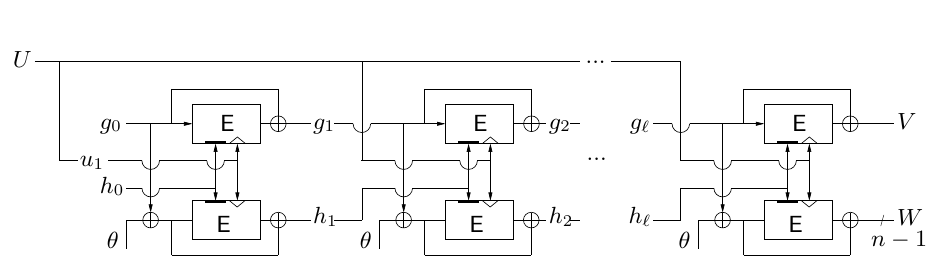
Figure 3: The hash function H upon a message U = u 1 k . . . k u ‘ +1 of ‘ + 1 blocks, with initial vector g 0 k h 0 . For each square, the input to the triangle denotes the key input. θ is a domain separation constant used by the Hir [ E ] DBL compression